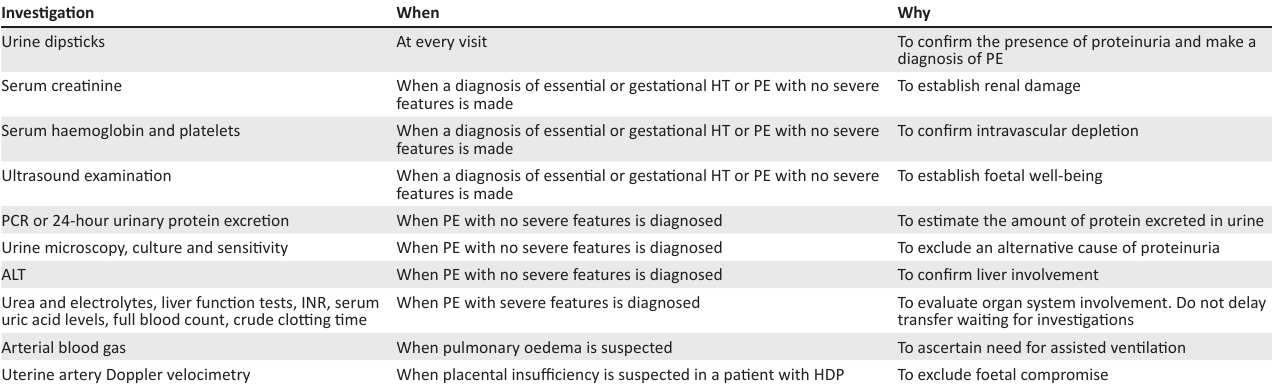
Arterial blood gas When pulmonary oedema is suspected Uterine artery Doppler